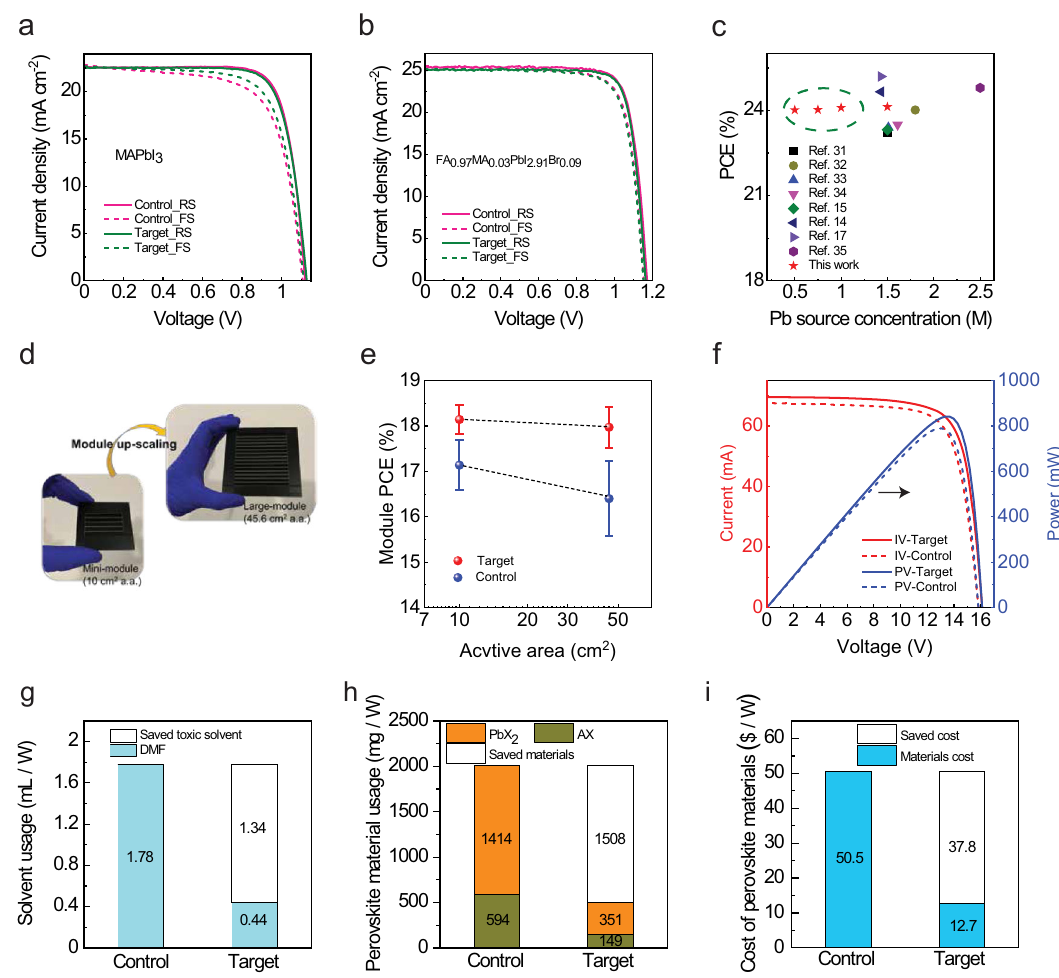
Fig. 5 Scalability and sustainability. J-V curves of PSCs based a MAPbI 3 and b FA 0.97 MA 0.03 PbI 2.91 Br 0.09 perovskites. c Comparison of PCE in the literature and this work is based on different co-solvent dilution ratios. d Photograph images of the up-scaling program via fabrication of mini- and large perovskite modules by the co-solvent dilution strategy (Photo credit: Narges Yaghoobi Nia). e Statistic overview on the reproducibility of the co-solvent dilution versus control high concentrated modules in fl uencing by the module active area. f I – V curves of champion large perovskite modules fabricated with high concentration control percussor and co-solvent diluted precursor. g – i Cost and waste generation analysis for module fabrication with and without